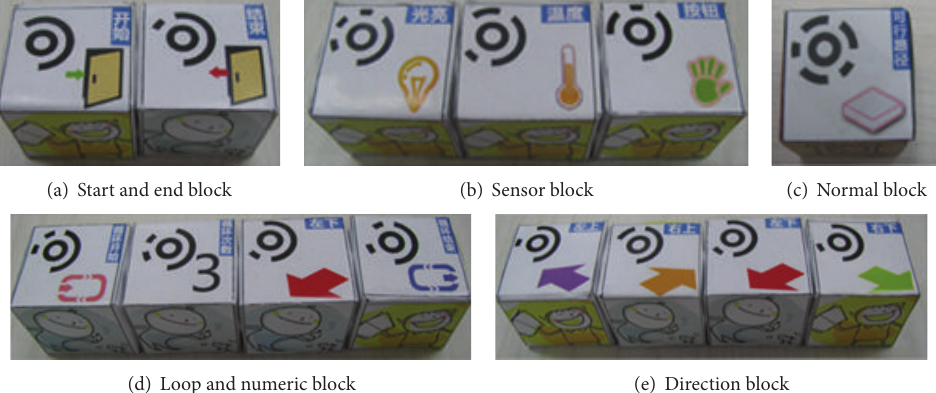
Figure 2: Tangible programming blocks.